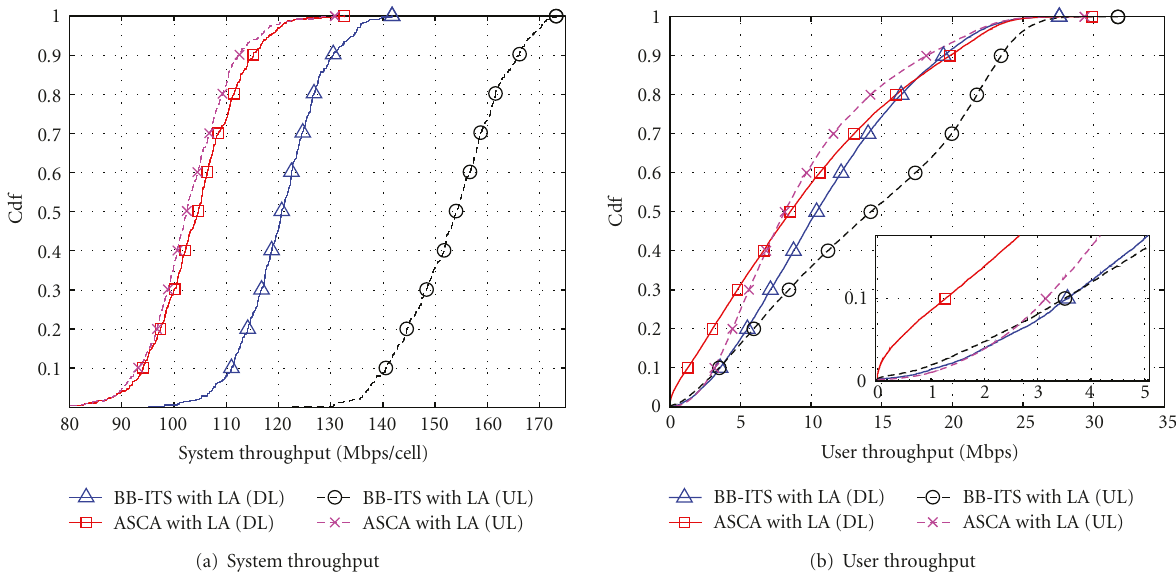
Figure 10: Cdfs of system and user throughputs for BB-ITS and ASCA with LA. In the DL, the users that are located at the cell-edge benefit whereas in the UL the users that are located closer to their desired BS